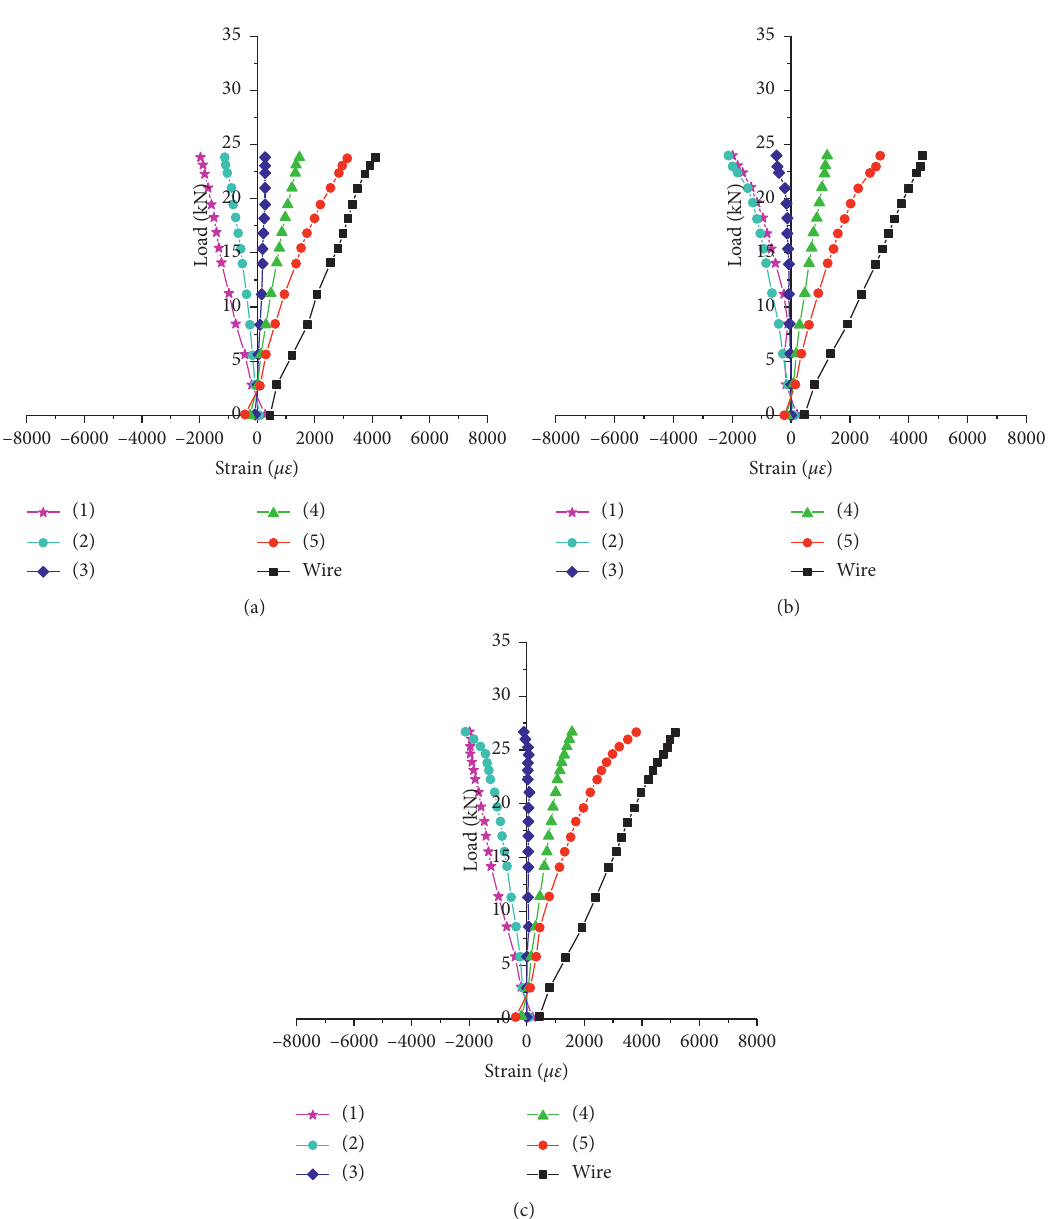
Figure 9: Load-strain relationship curve in group B. (a) SPF1.2. (b) SPF2.2. (c)